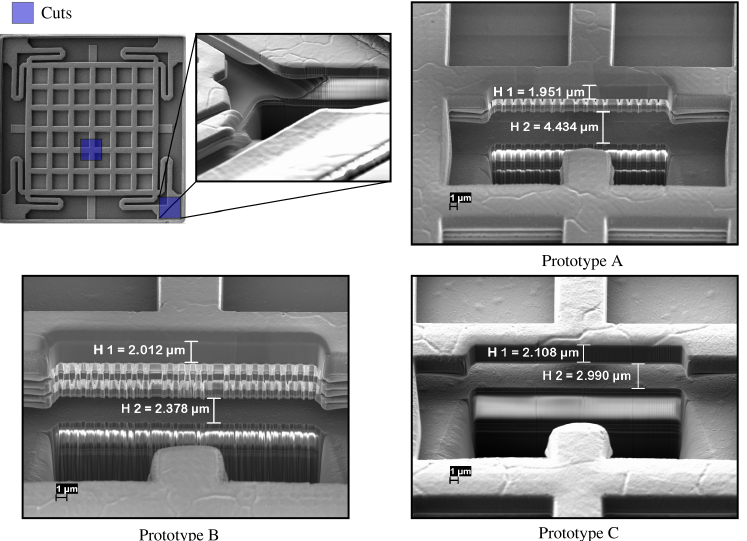
Figure 4. SEM image of the manufactured prototypes and the cross-section of each of them after the post-CMOS realization based on an isotropic wet etching without a mask of a 30 min step. As it can be seen in the image of the cuts, the cut made in the resonator corner, has been executed to see the penetration of the acid and the correct release of the springs. On the other hand, the images of the cross-sections of each prototype illustrate a variation both in the thickness of the top metal ( H 1 ) and the air gap of each one ( H 2 )